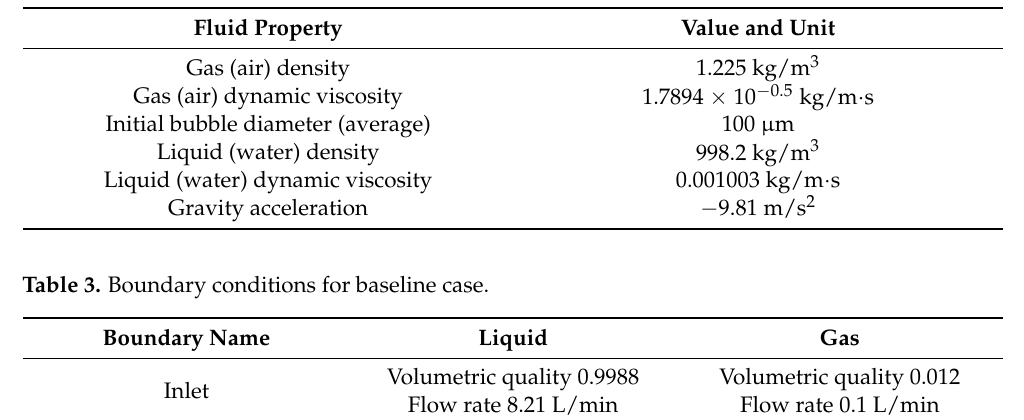
Table 2. The physical properties of water and air.